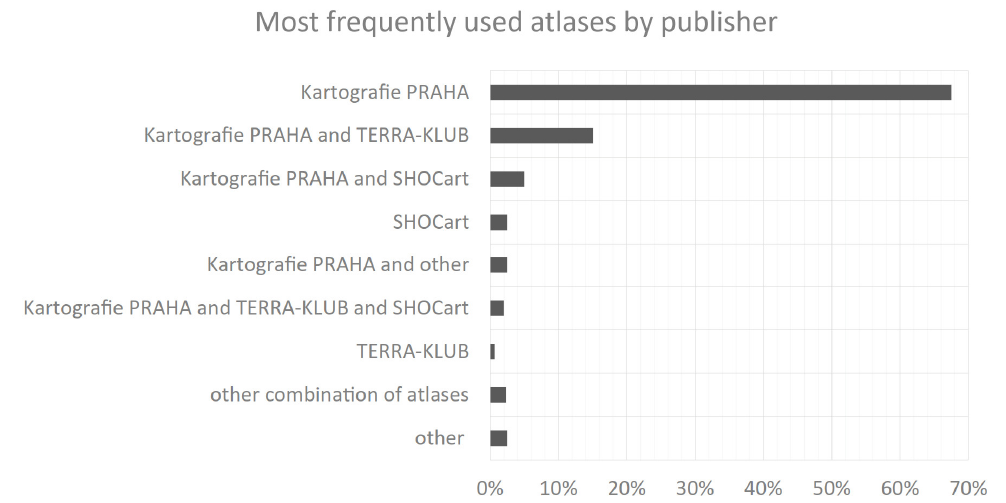
Figure 4. Summary of Q2—Most often used atlases in Czech schools.